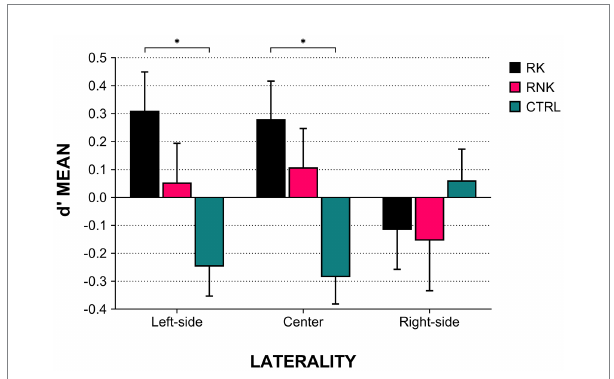
FIGURE 4 Kick outcome prediction according to group and laterality. The histograms indicate the average d ’ scores, error bars indicate standard error. Asterisks indicate post hoc values of p < 0.05. RK, Rugby Kickers; RNK, Rugby Non-Kickers; and CTRL, control